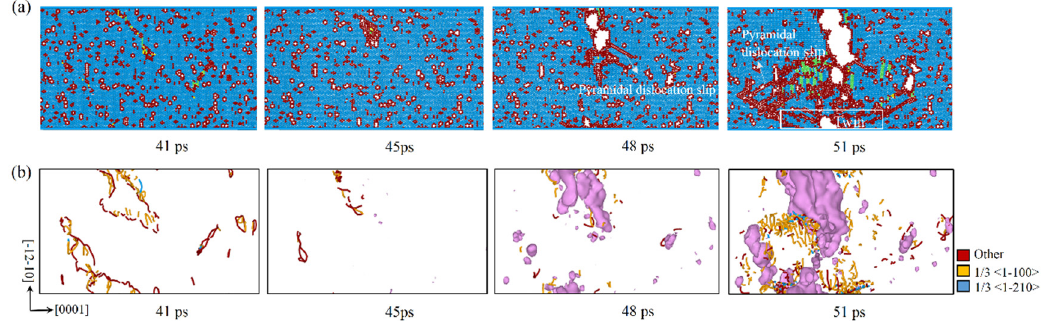
Figure 6. Void evolution of the sample with C v = 2.0% at different time points during initial spallation loading along the [0001] direction. ( a ) Atomic configurations of a chosen section of the spall region. ( b ) Mechanism of void growth based on dislocation emission is analyzed using DXA: 1/3 <1–100> partial basal dislocations, 1/3 <1–210> partial prismatic dislocations, other dislocations (mainly 1/6 <20 – 23> and 1/9 <01 – 13> partial dislocations), etc., are presented. For the sample with C v = 2.0% (Figure 6), the plastic deformation pattern at the initial spallation stage was similar to the sample with C v = 1.0%, with some key differences. At